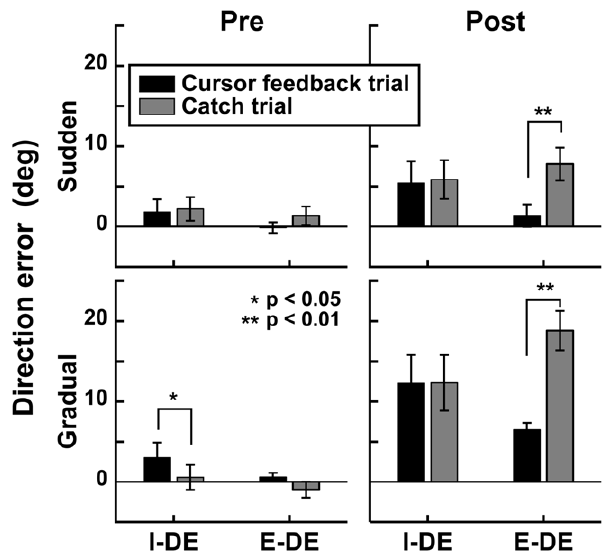
Figure 3. Catch trial effects. Each panel shows the mean I-DEs and E- DEs of cursor feedback trials (black bars) and catch trials (gray bars) across subjects. The asterisks (* and **) denote the significance of differences: p , 0.05 and p , 0.01, respectively. Error bars denote the SE. Left and right panels indicate the pre- and post-training phases, respectively. Top and bottom panels indicate the sudden and gradual conditions, respectively. Note that the cursor-feedback trials with the same visual target as the catch trials were selected to calculate the mean I-DE and E-DE.